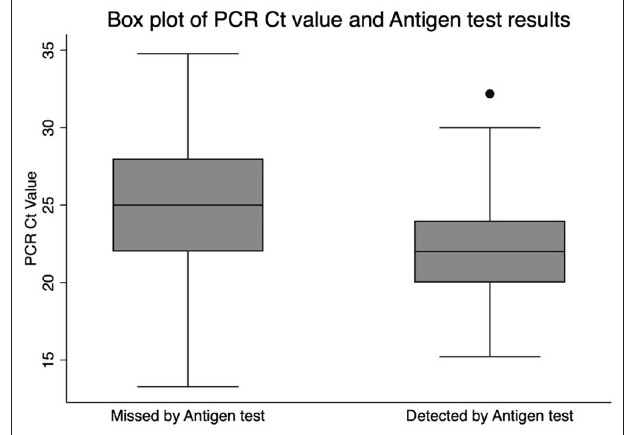
FIGURE 1 | Box plot of PCR Ct value and Antigen test